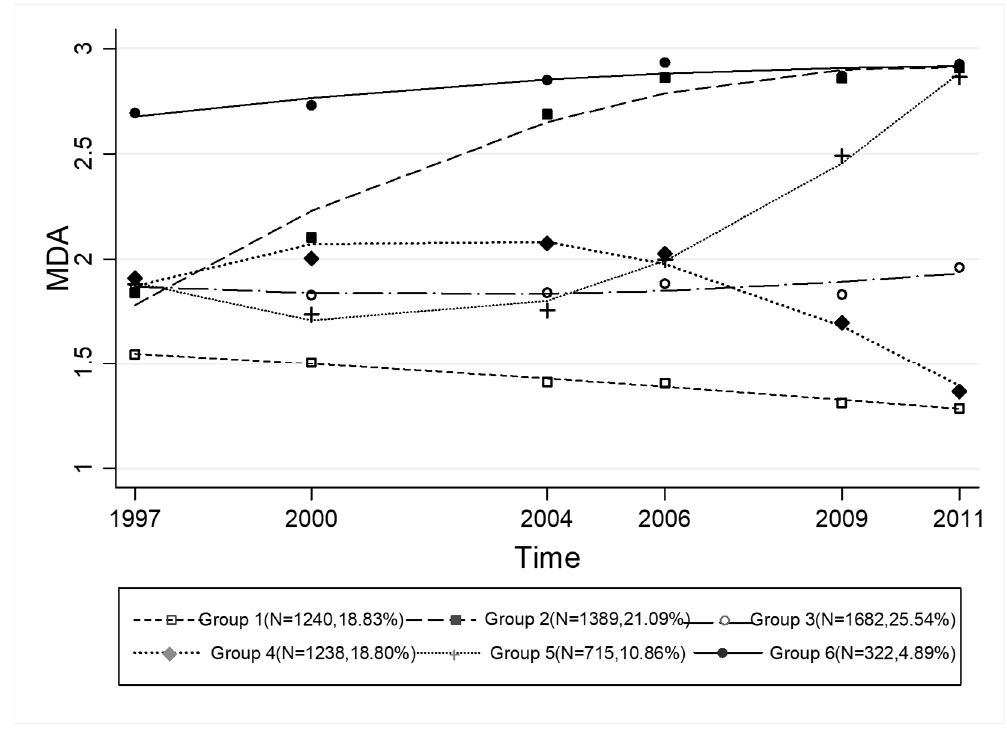
Figure 1. MDA trajectory groups showing differences across waves (6 groups).